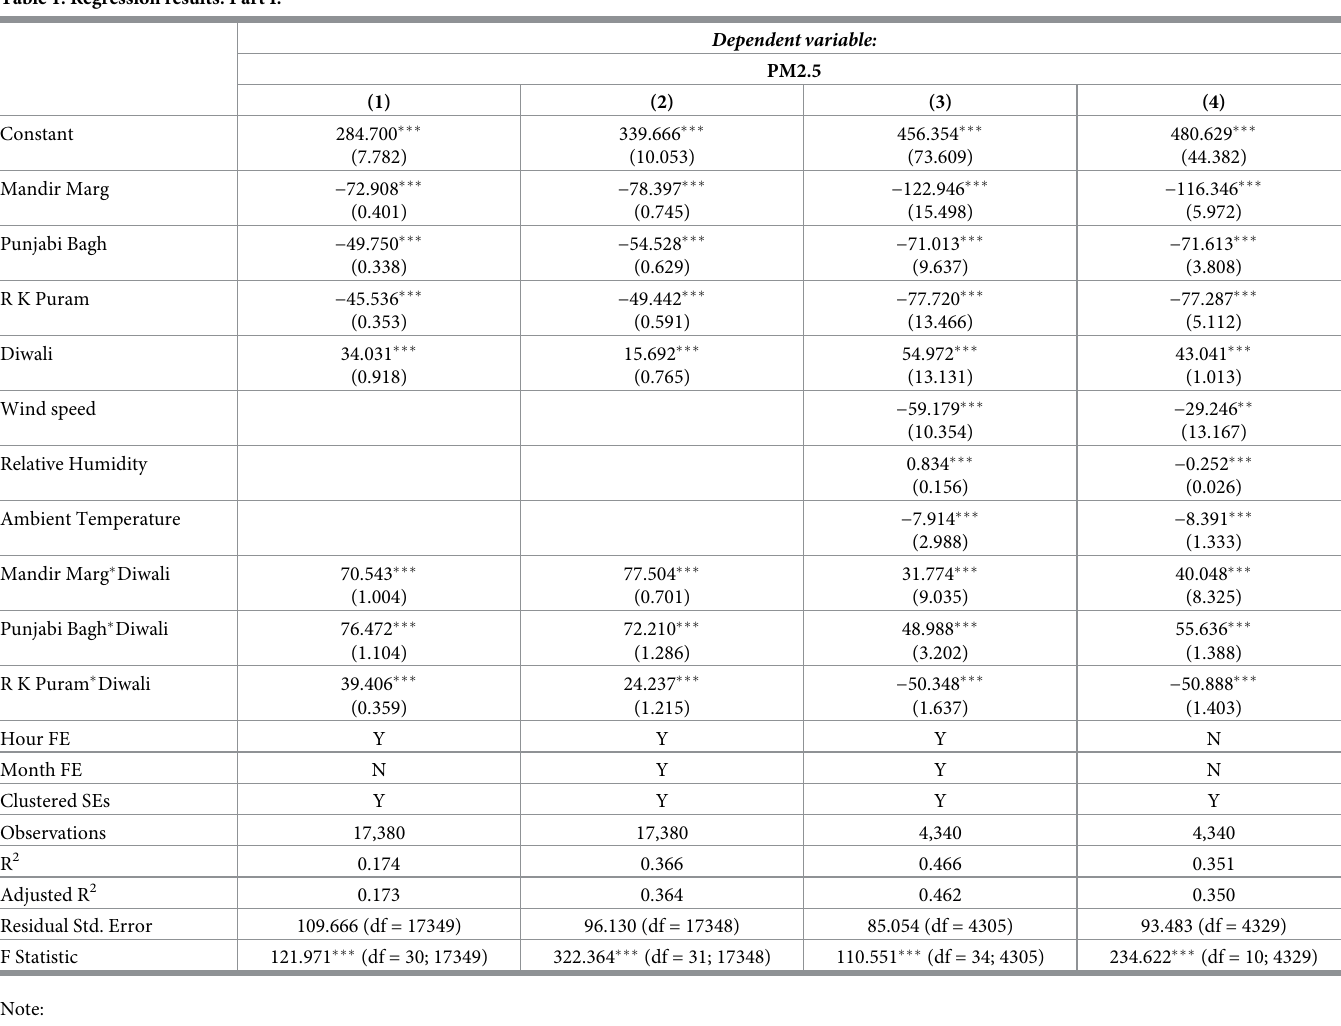
Table 1. Regression results: Part